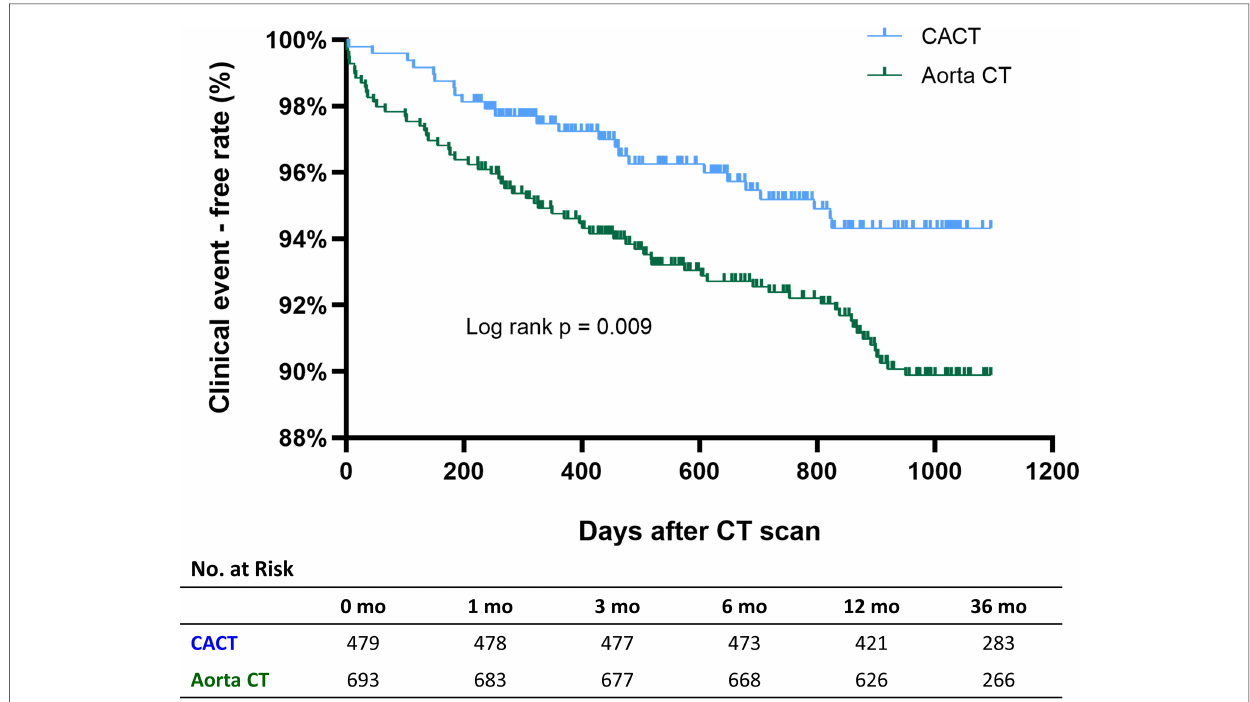
FIGURE 3 Incidence of all-cause death or myocardial infarction according to CT protocol. Aorta CT, thoracoabdominal aorta CT angiography protocol; CACT, coronary-aorta CT protocol; CT, computed tomography.